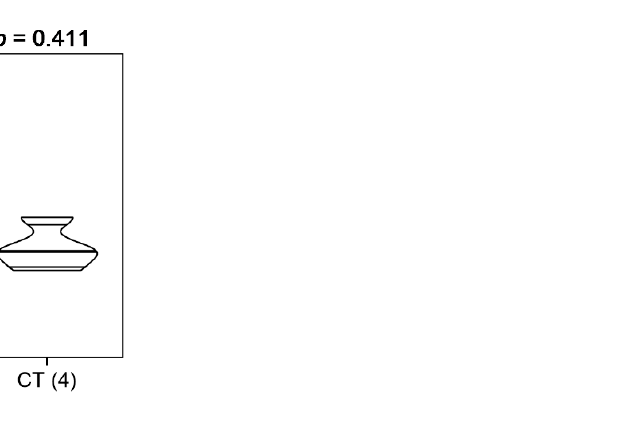
Figure 3. Correlation between rs144160282 genotypes and NRG1 expression. Data were calculated using HapMap3 lymphoblastoid cell data. Values in brackets represent the number of samples.